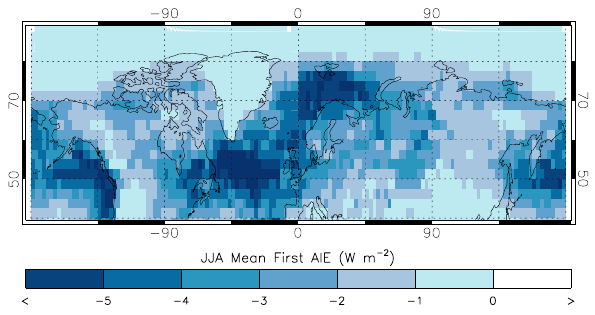
Fig. 9. Summertime (JJA) mean first AIE from monoterpene SOA when the Org1 nucleation mechanism is used (expt.